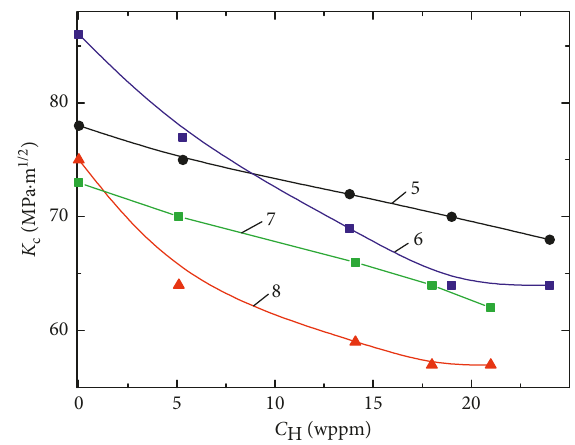
Figure 4: Dependences of fracture toughness K c at hydrogen pressure of 30MPa of specimens of 10 (7), 20 (5, 8) and 25 (6) mm thickness on the hydrogen content C H at a strain rate of 0.1mm/min. The numbers near curves correspond to ordinal numbers in Table